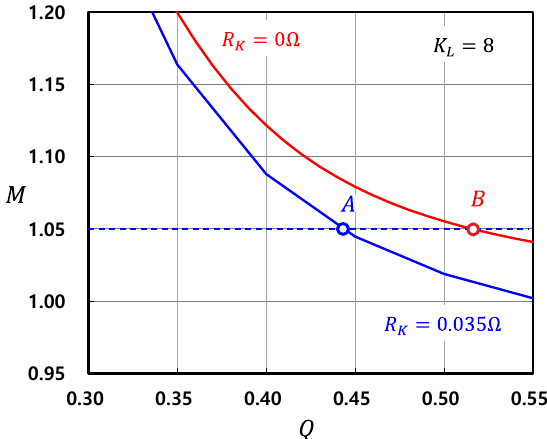
Figure 13. Internal loss resistance and change in Q value. Table 3. Design Conditions for LLC Resonant Converters.